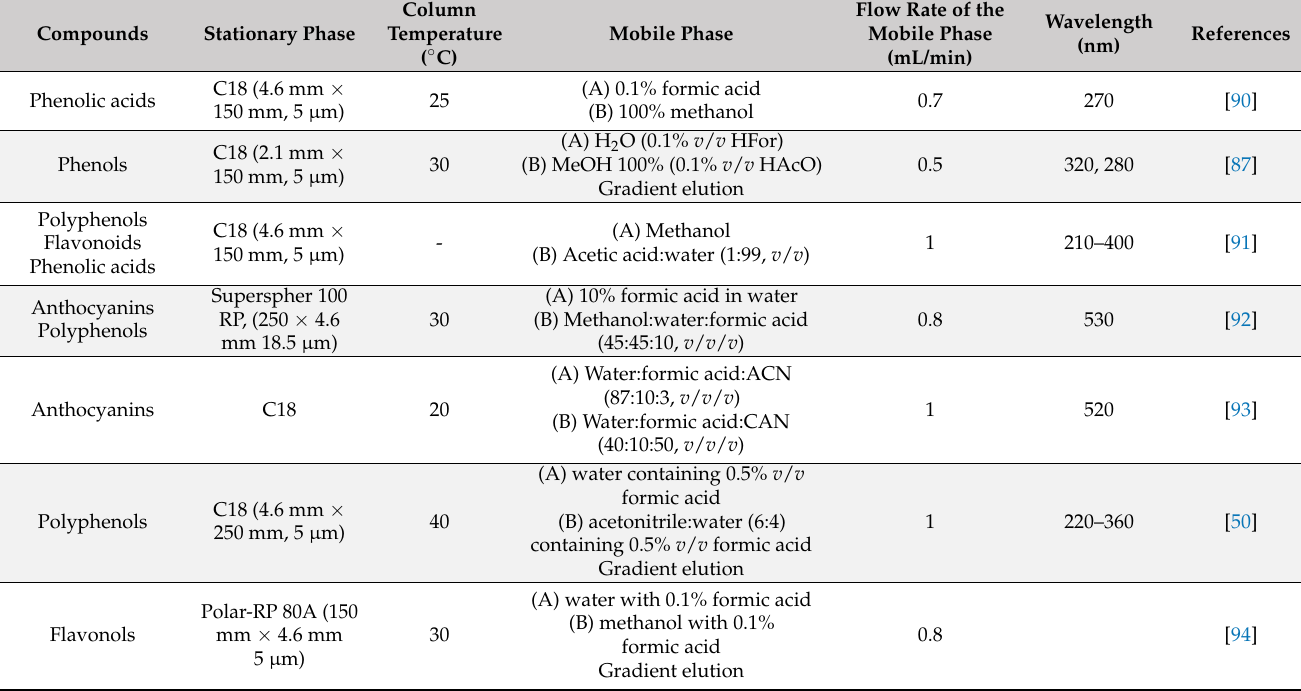
Table 2. HPLC experimental conditions for the determination of some classes of phenolic